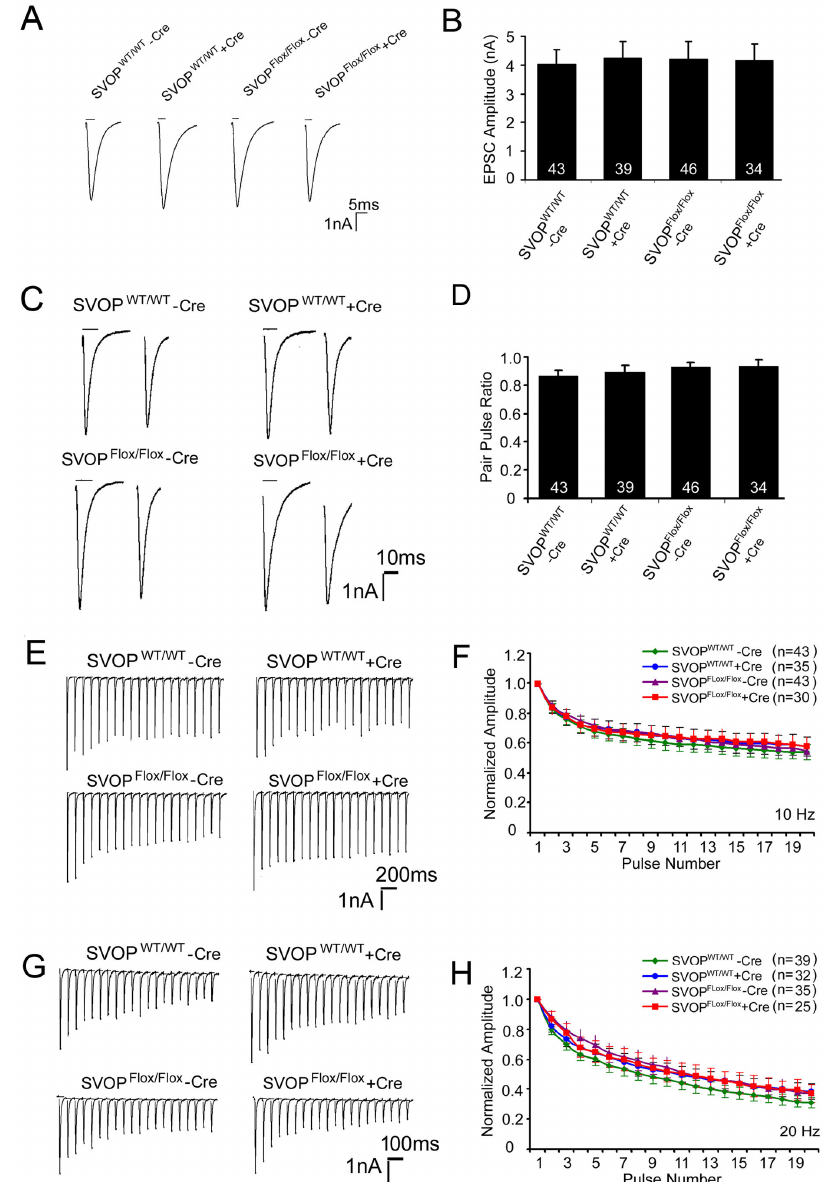
Figure 4. Loss of SVOP has no effect on action-potential evoked transmitter release or short-term plasticity. Neuronal cultures were generated and infected as described in Figure 3 . A) Representative traces of single EPSCs. Neurons were held at −60 mV, and single EPSCs were evoked by depolarizing to +20mv for 1 ms. B) Average EPSC peak amplitudes of each experimental group. Data are presented as mean ± SEM. The numbers of cells analyzed are indicated within each column. There was no significant difference in the peak amplitude of EPSC between experimental groups (SVOP WT/WT - Cre, 4.03 ± 0.51 nA; SVOP WT/WT + Cre, 4.24 ± 0.58 nA, SVOP Flox/Flox -Cre 4.20 ± 0.60 nA and SVOP Flox/Flox + Cre 4.15 ± 0.58 nA, p = 0.99, two-way ANOVA). C) Representative traces of paired responses. Autaptic neurons were stimulated with two 1ms pulses separated by 45 ms. D) The paired-pulse ratio (PPR) (EPSC peak amplitude response 2/ response 1) was calculated for each cell. The graph shows the mean ± SEM for each experimental group. All experimental groups showed synaptic depression with a mean PPR of less than 1. The mean PPR across experimental groups was indistinguishable ( p = 0.71, two-way ANOVA). E) Representative traces of EPSC in response to stimulus trains delivered at a frequency of 10 Hz. F) Shown are mean normalized EPSC amplitudes. Neurotransmission depressed at comparable rates in neurons from all experimental groups. Error bars represent the SEM for each point. The number of cells analyzed is indicated in parentheses. Data are from 10 different cultures. G , H ) 20 Hz stimulus trains produced similar synaptic depression across